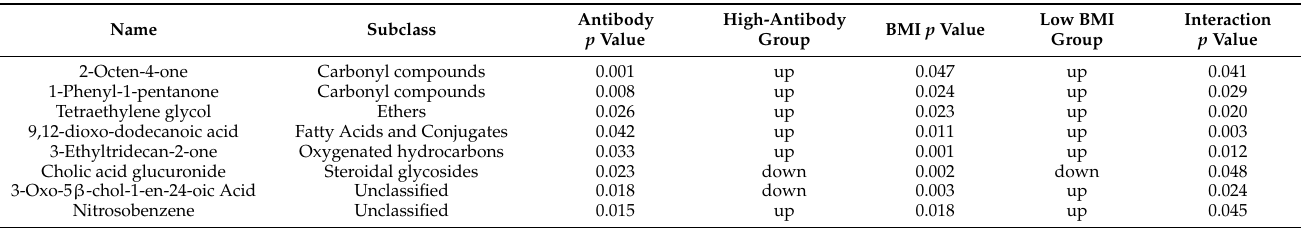
Table 1. The interaction between antibodies and BMI mediated by